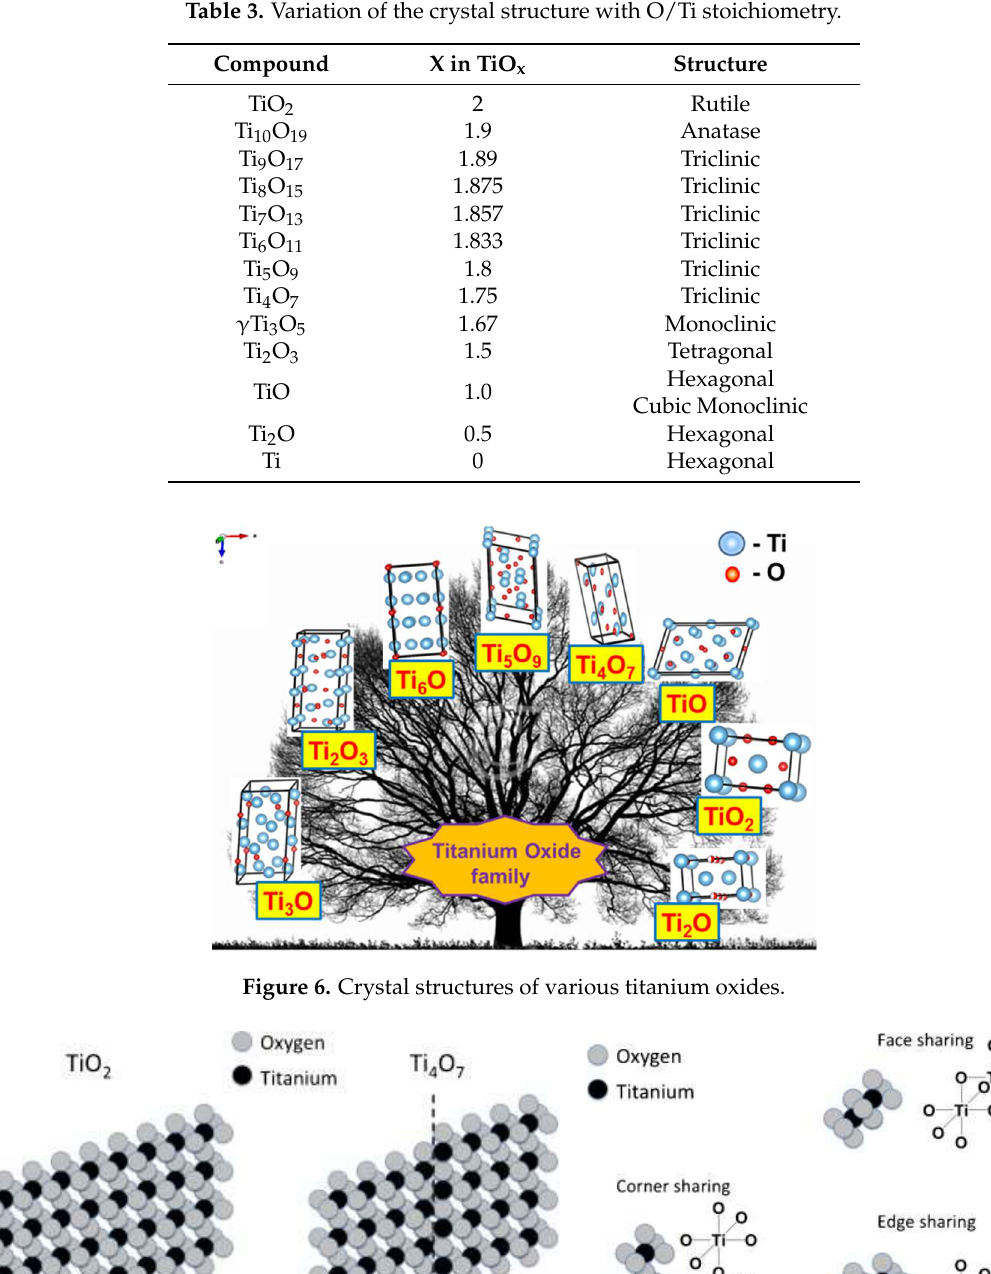
( b ) Figure 7. ( a ) Difference between TiO 2 and Ti 4 O 7 (Magneli phase) structure ( b ) Different orientations of TiO 2 octahedra in Magneli phase materials. Reproduced from [92], Copyright 2010, Elsevier. 